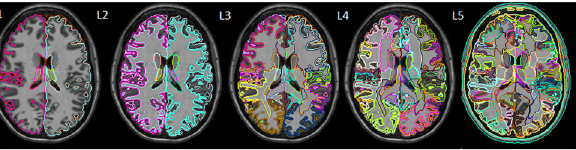
Fig 1. Brain parcellation scheme of the JHU multiple atlases. Multiple granularity levels (L1 to L5) are shown. Level 5 (L5) has the highest granularity and defines 286 regions. An anatomy-based hierarchical relationship was established to generate super-structures and lower-granularity parcellation, as shown in L1 –